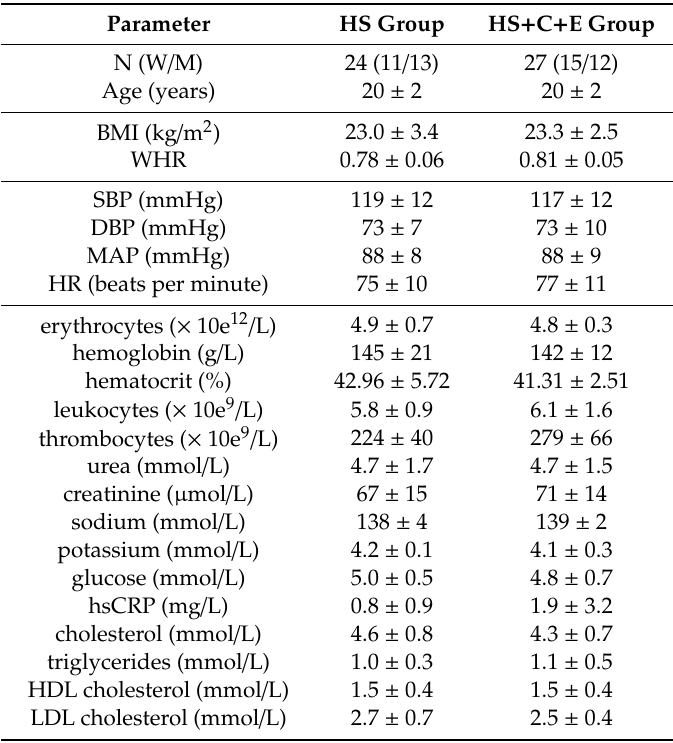
Table 1. Initial anthropometric characteristics of the study population at the beginning of the study protocol